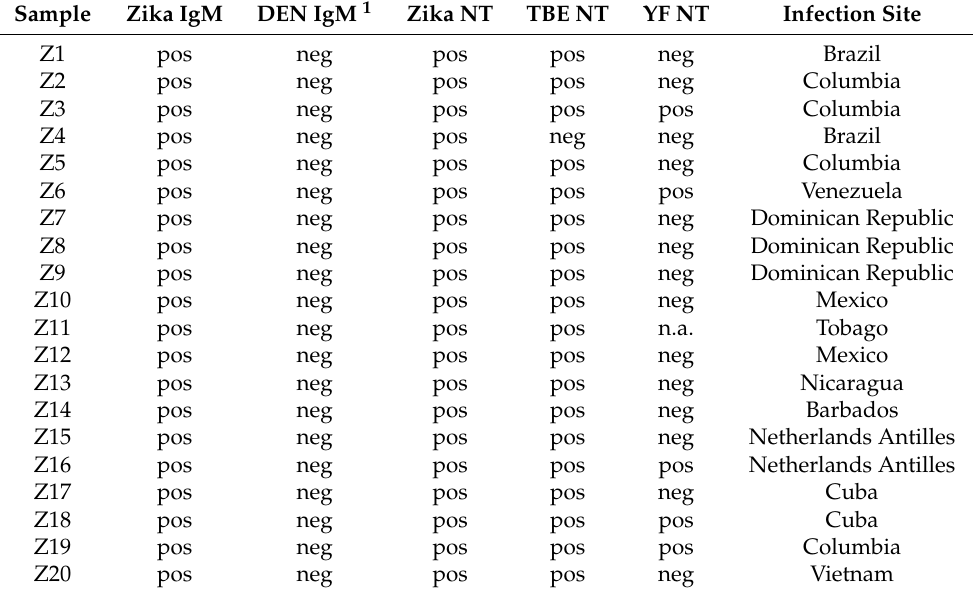
Table 3. Characteristics of Zika serum samples obtained from travelers who returned to Austria from Zika-endemic regions, 2016–2017, as determined by routine diagnosis.